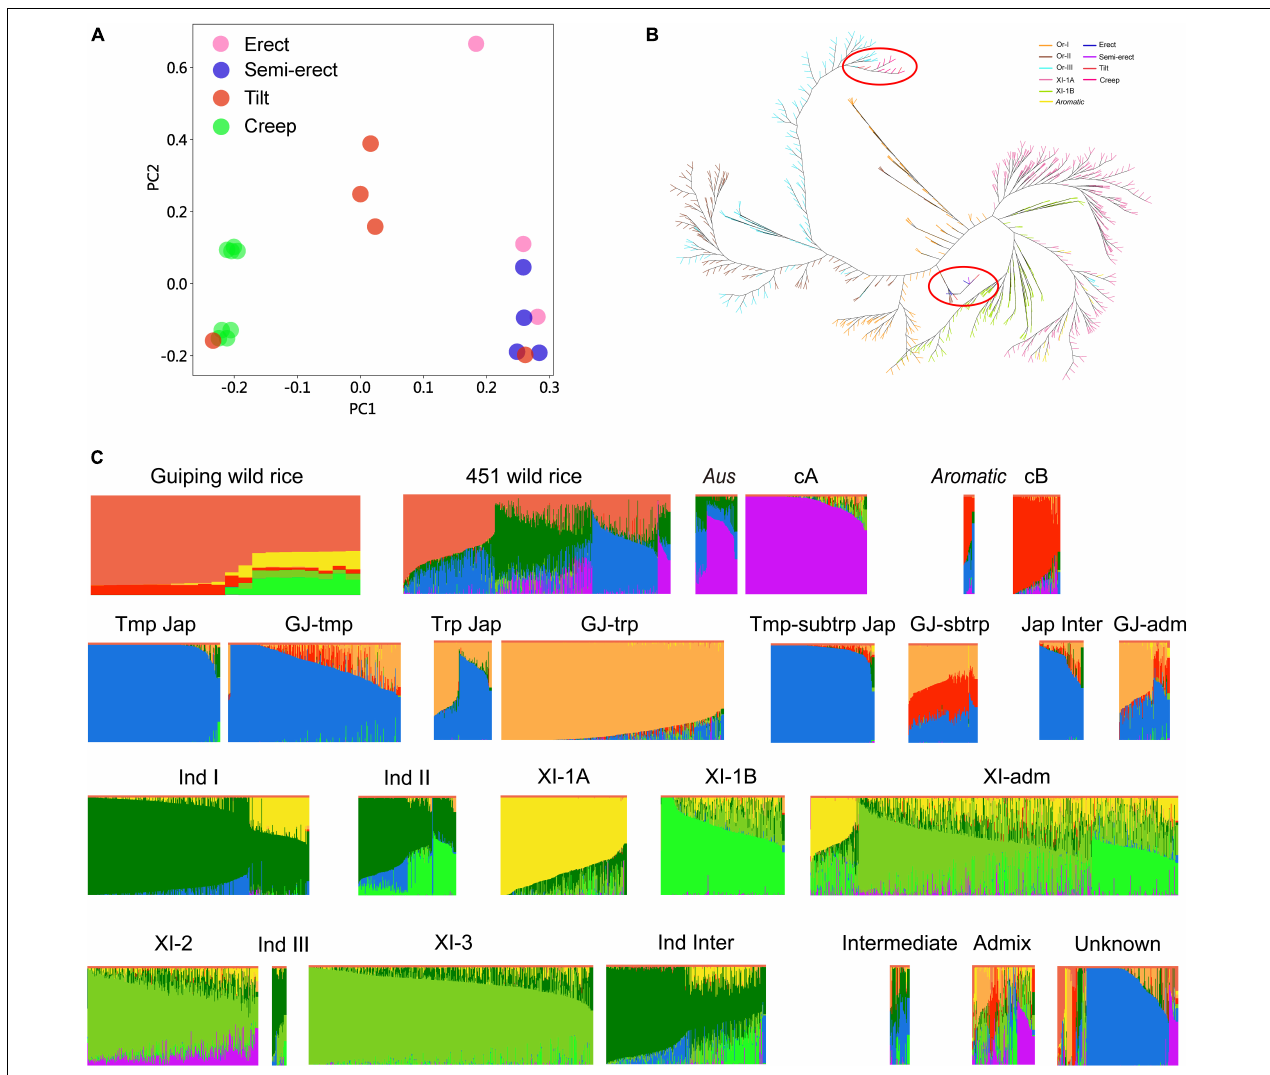
FIGURE 2 | Genetic structure and association analyses of the Guiping wild rice population. (A) Principal component analysis of 20 individuals from the Guiping wild rice population. (B) Neighbor-joining tree of the Guiping wild rice population, 451 O. rufipogon accessions, 209 XI-1A accessions, 205 XI-1B, and 96 aromatic accessions analyzed in an earlier study (Huang et al., 2012). On the basis of approximately 5 million SNPs, the following groups were identified: Or-I (orange), Or-II (brown), Or-III (light blue), XI-1A (pink), XI-1B (green), aromatic (yellow), erect (dark blue), semi-erect (purple), tilted (red), and creeping (rose red). Guiping wild rice were marked with red cycles. (C) Ancestry of the 20 individuals from the Guiping wild rice population. Genomic data for 451 wild rice accessions were obtained from a published study (Huang et al., 2012). Data for the other 5,152 cultivated rice accessions were downloaded from the Genome Variation Map database (see